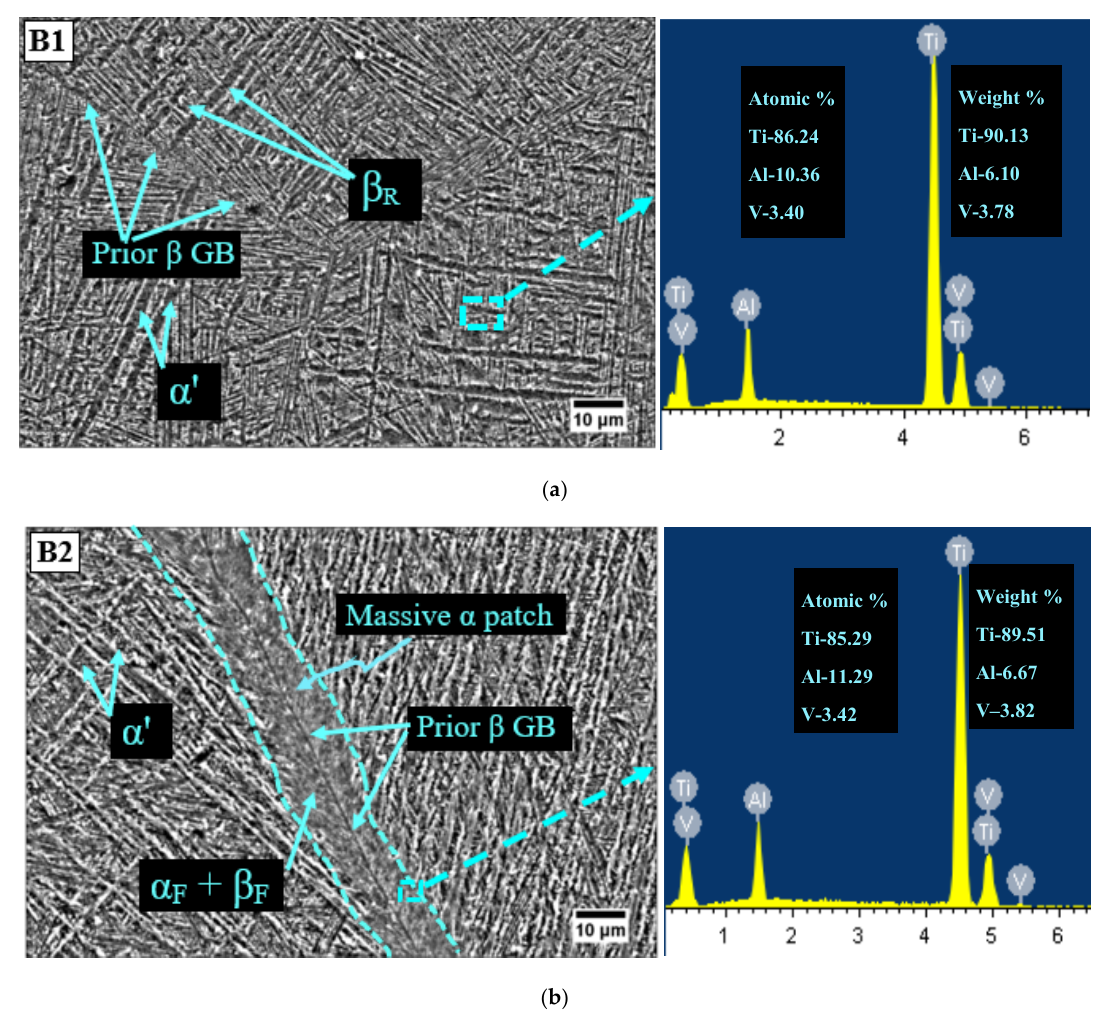
Figure 3. Microstructure of Ti-6Al-4V ELI for ( a ) the B1 specimen (β-solution treatment (1035 °C/1 h, water quenching (WQ)) + aging (600 °C/2 h, air cooling (AC))) and ( b ) the B2 specimen (β-solution treatment (1035 °C/1 h, WQ) + aging (600 °C/2 h, AC) + deep cryogenic treatment (DCT; −196 °C/24 h) + tempering (170 °C/4 h, AC)).